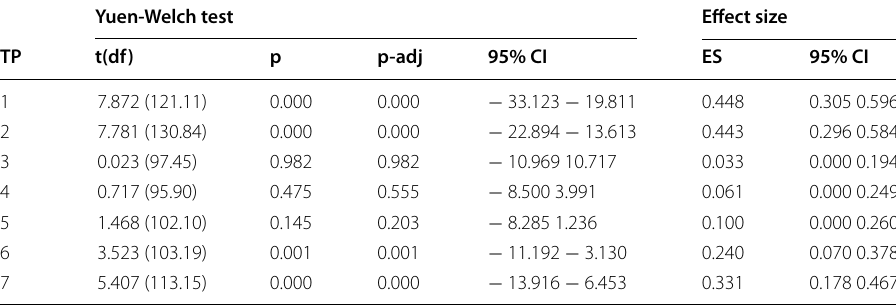
Table 3 Comparison of experimental conditions (control, non-gamified; and experimental; gamified) in terms of participant attempts for each point in time